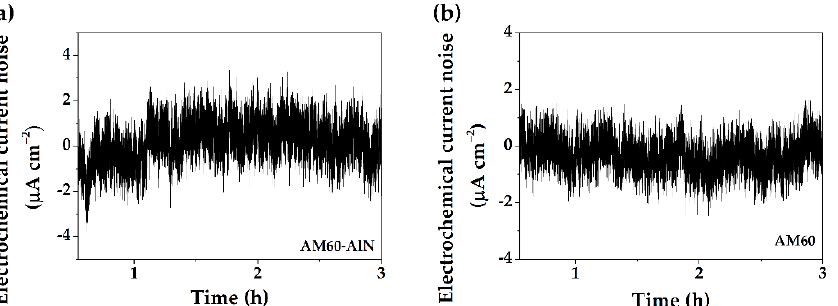
Figure 5. Electrochemical current noise signals (at OCP) of ( a ) AM60-AlN nanocomposite and ( b ) AM60 alloy at 30 days of immersion in SME model solution.